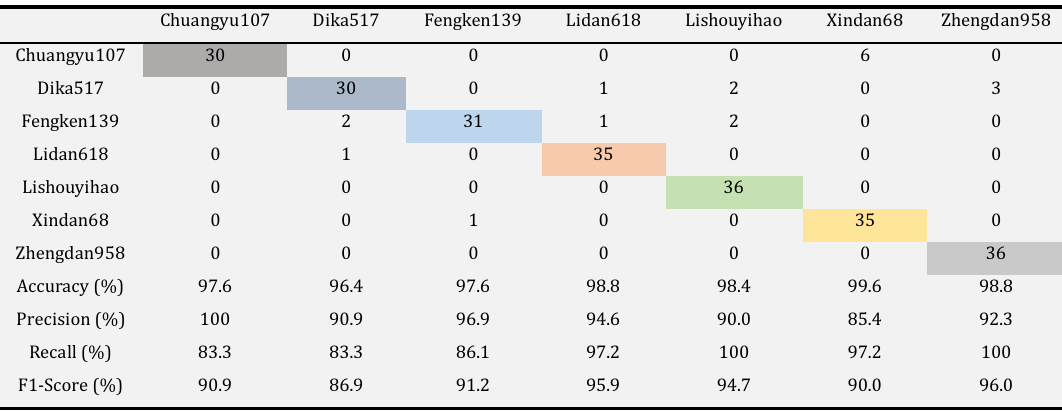
Table 9. Model applicability test Confusion